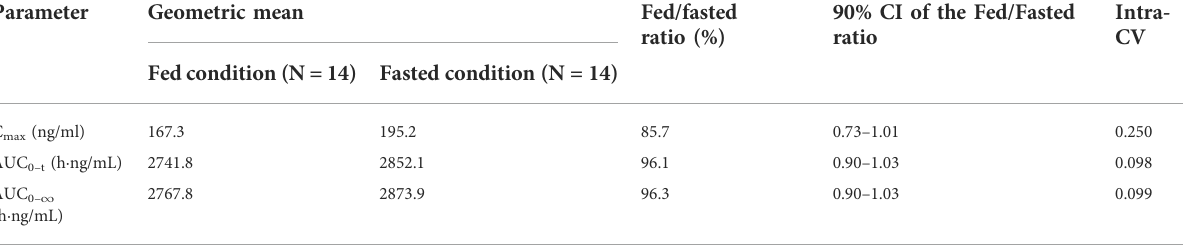
TABLE 3 Statistical comparison of primary pharmacokinetic parameters of WXFL10203614.